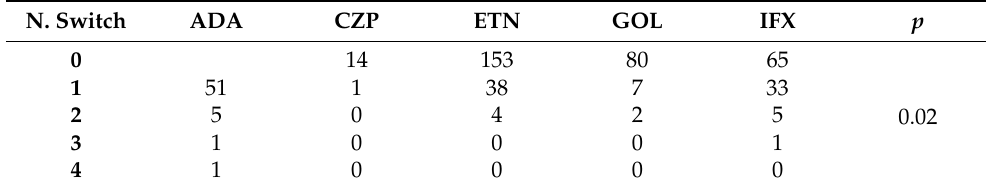
Table 4. No. of switches among anti-TFN bDMARDs.